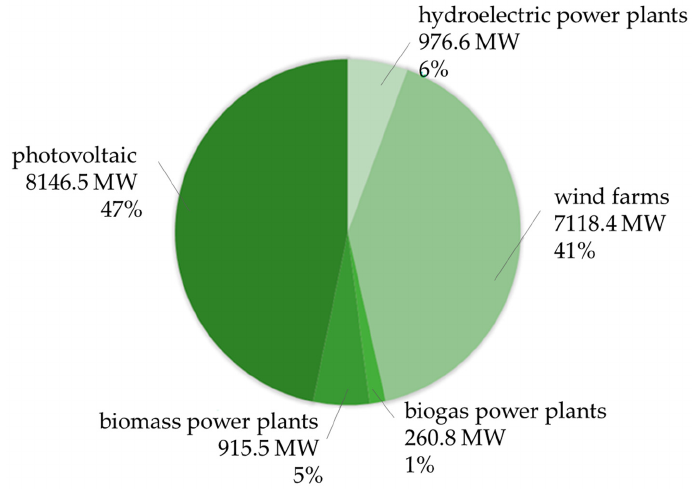
Figure 1. Installed capacity of RES power plants in Poland in 2022.